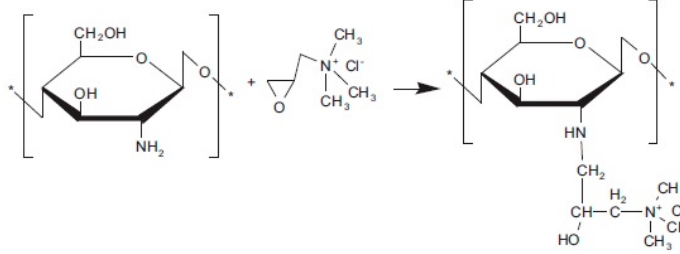
Figure 13. Reaction of CS with glycidyltrimethylammonium chloride [176]. Copyright 2013, reproduced with permission from Elsevier